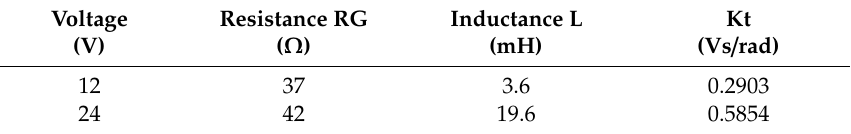
Table 5. Comparison of 12- and 24-V-DC-Generator Parameters.